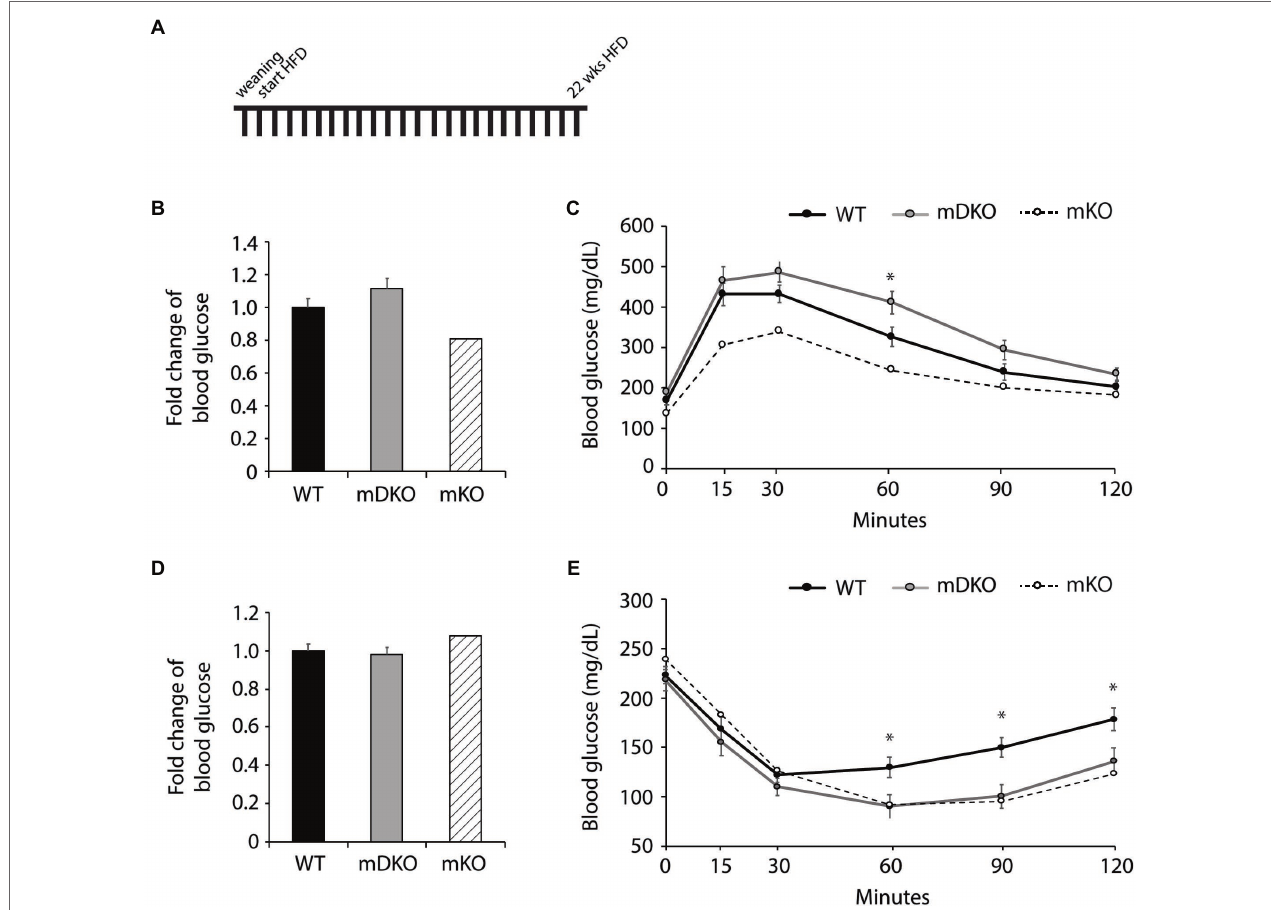
FIGURE 4 | Glucose and insulin tolerance testing after 22 weeks of HFD feeding. (A) Schematic of HFD-feeding. (B) Resting blood glucose levels after 16 h of fasting in WT and mDKO mice. Values are normalized to WT means. (C) Glucose tolerance test of WT and mDKO mice. Values are means ± SEM. (D) Resting blood glucose levels after 4 h of fasting in WT and mDKO mice. Values are normalized to WT means. (E) Insulin tolerance test of WT and mDKO mice. Values are means ± SEM. n = 7–10. * p < 0.05 when compared to WT. Values of striped bars are means from 5 muscle-specific OGT knockout mice (mKO) for